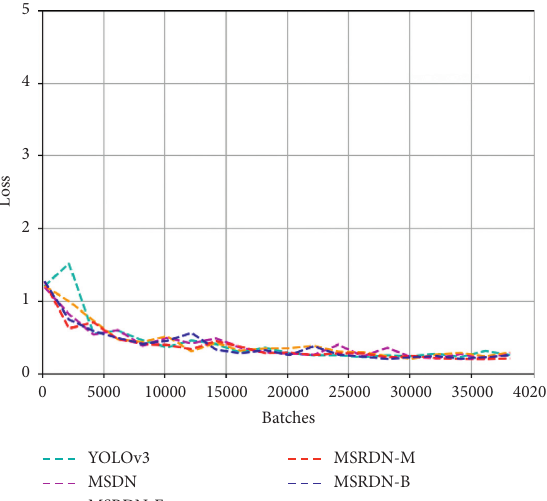
Figure 14: The comparison of loss